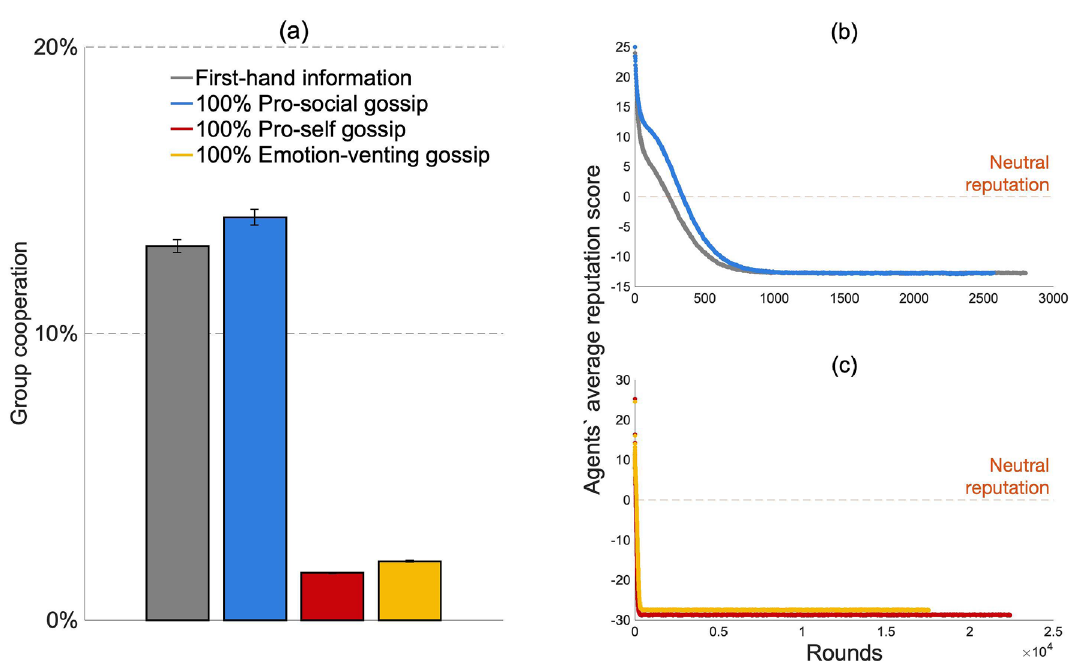
Figure 6. Results for lenient agents when they were randomly matched. ( a ) Average group cooperation for first-hand information and gossip motives. Number of cooperative interactions over rounds for groups ( b ) with first-hand information and groups with 100 % pro-social gossip, and ( c ) with 100 % pro-self and 100 % emotion- venting